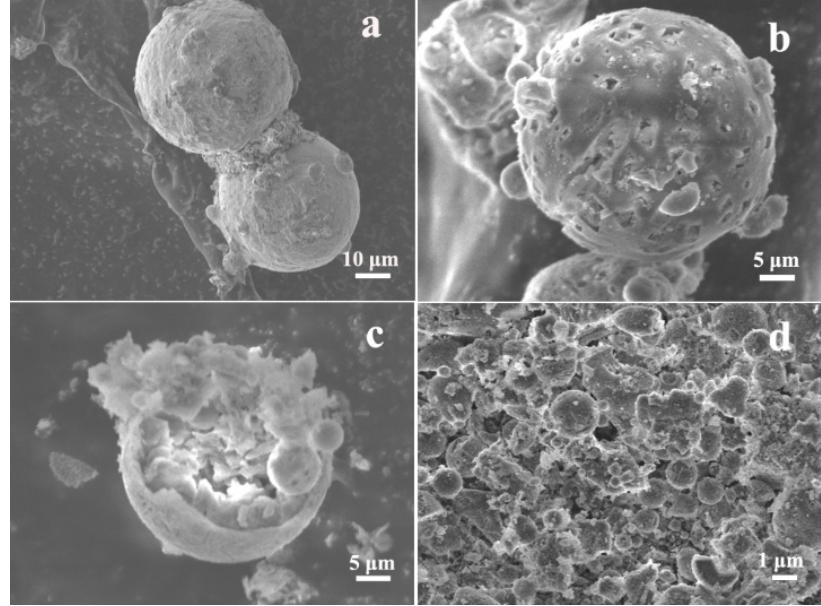
Figure 14. SEM images of CFA and residue after calcination at 230 °C for different durations: ( a ) CFA; ( b ) 1 h; ( c ) 2 h; ( d ) 3 h.